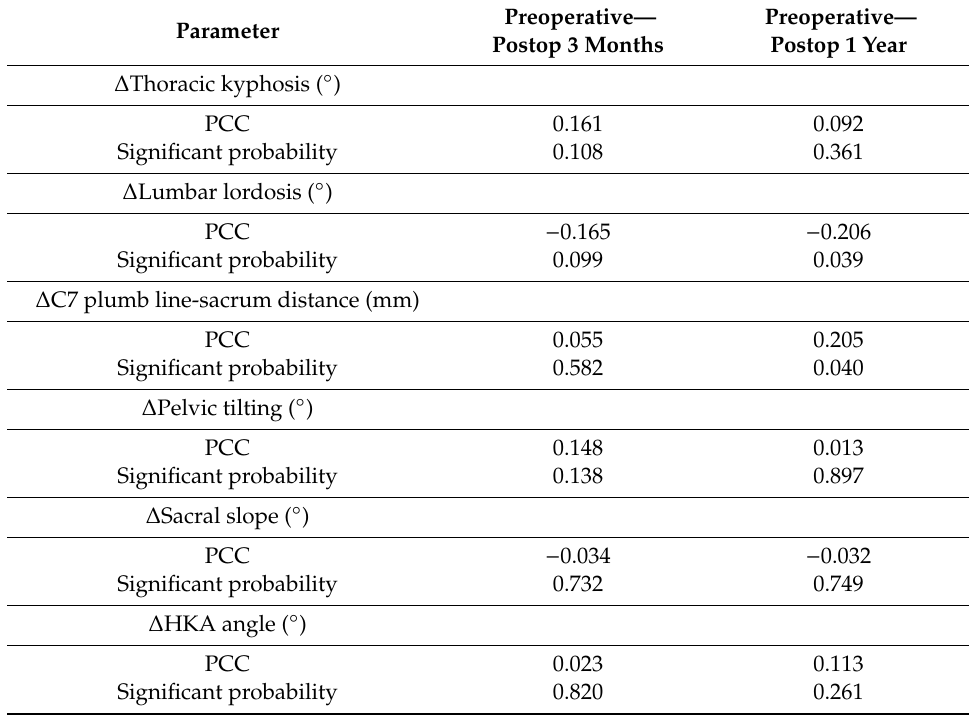
Table 2. Correlation analysis between lumbar flexibility and sagittal